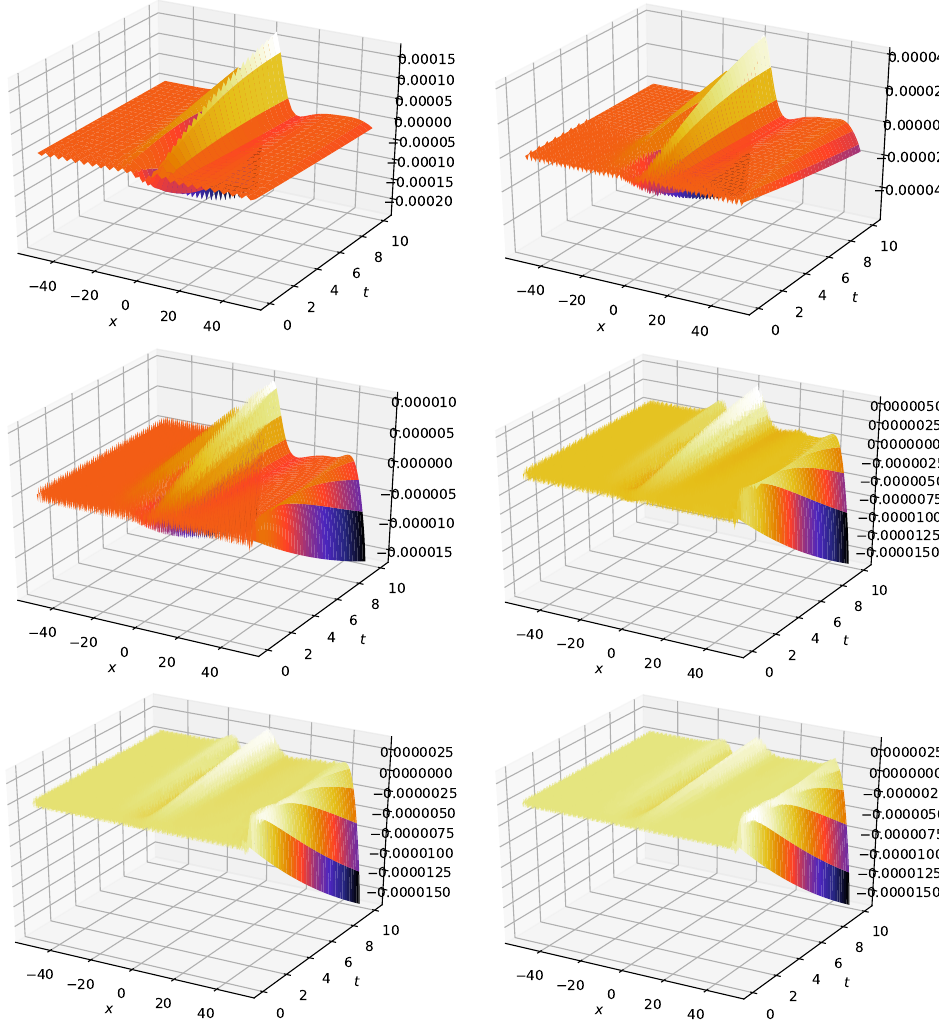
Figure 11. 3D plot of error of KdV–Burgers when N = Nt = 50,100 (top: left to right), N = Nt = 200,300 (middle: left to right) and N = Nt = 400,500 (bottom: left to